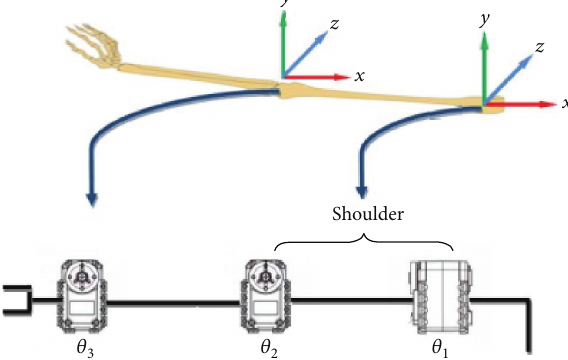
Figure 4: Human arm and manipulator robot